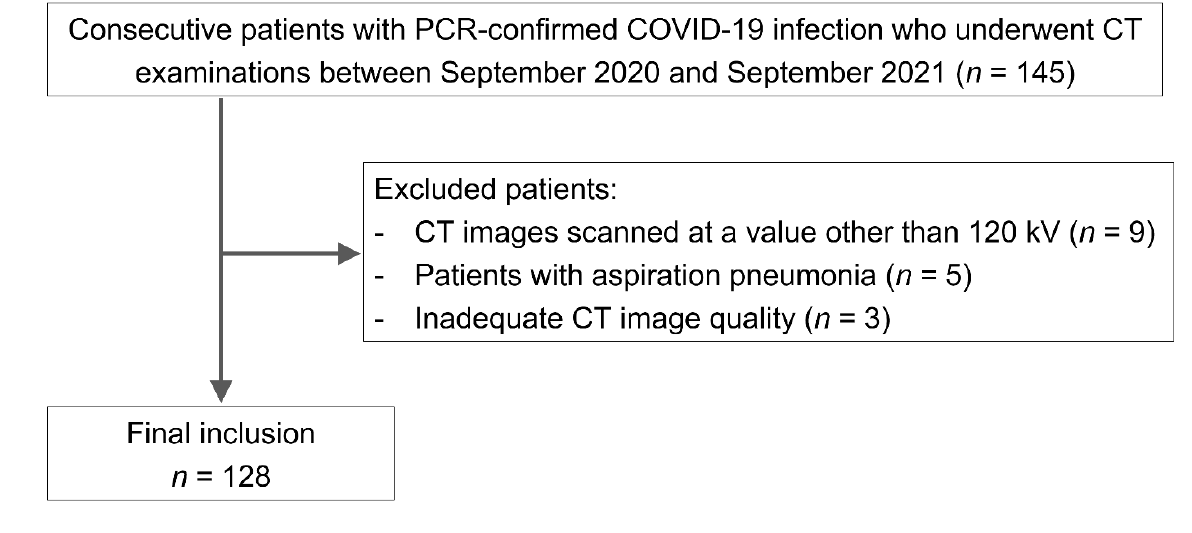
Figure 1. Flowchart of patient selection.